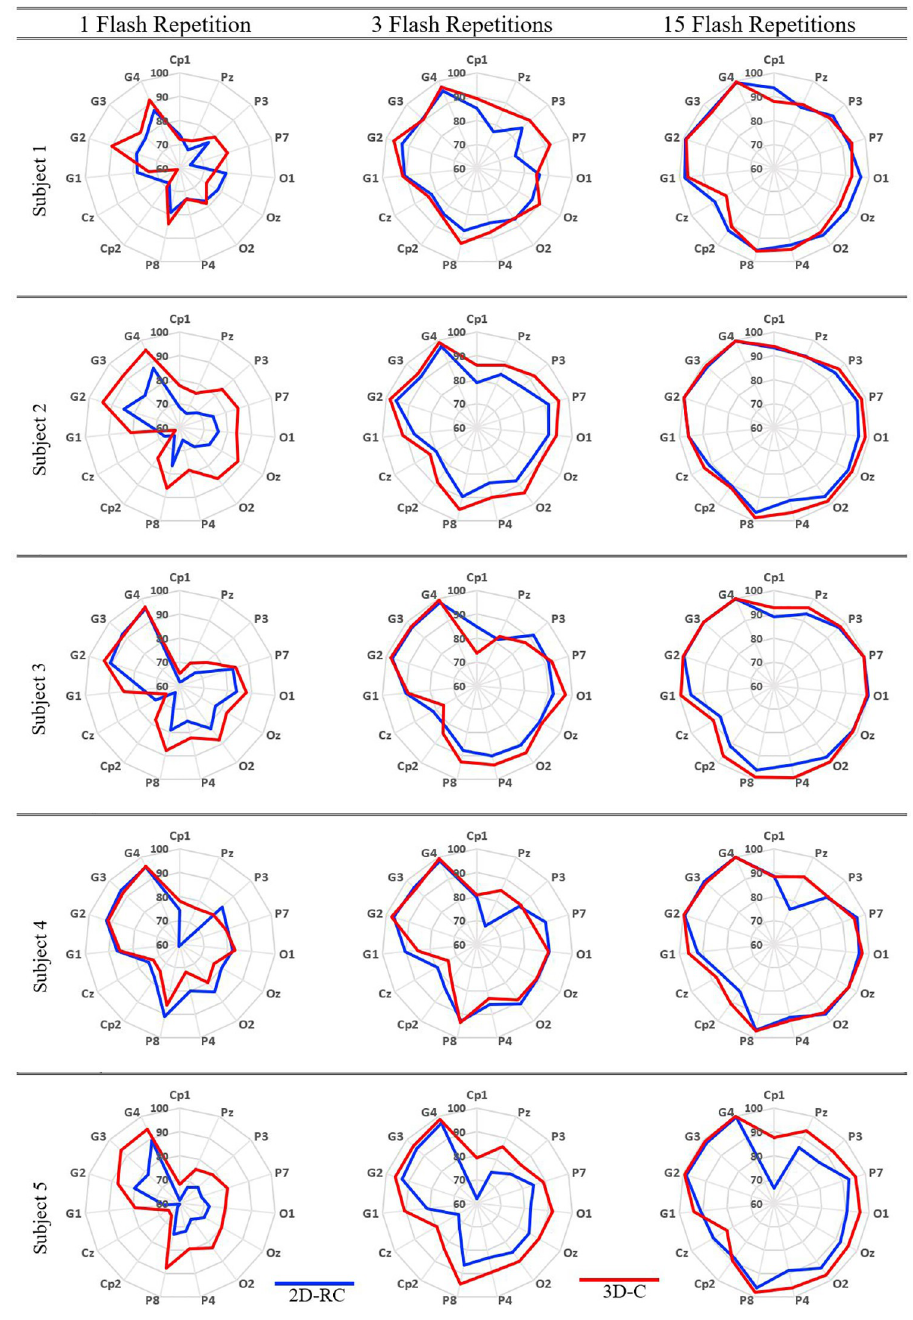
Fig 13. Different repetitions result for subjects